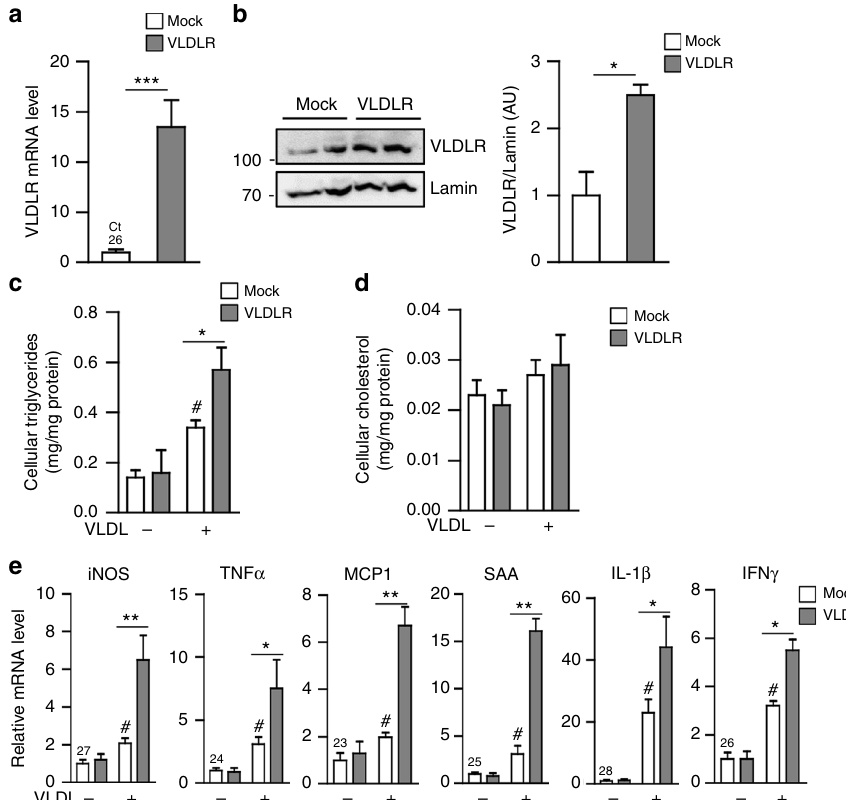
Fig. 2 Macrophages overexpressing VLDLR accumulate triglycerides and induce expression of pro-in fl ammatory genes in the presence of VLDL. Peritoneal macrophages were transfected with pcDNA3.1-mock (Mock) vector or pcDNA3.1-VLDLR (VLDLR) expression vector. Total RNA was isolated to analyze VLDLR mRNA expression ( a ) and whole cell lysates were extracted for western blot analysis ( b ). c – e Human VLDL (30 μ g/ml) was treated to cultures of peritoneal macrophages that had been transfected or not with VLDLR overexpression vector. Intracellular triglyceride ( c ) and cholesterol ( d ) levels in peritoneal macrophages. e mRNA levels of pro-in fl ammatory genes were analyzed with (+) or without ( − ) human VLDL challenges in peritoneal macrophages. Each mRNA level was normalized to cyclophilin mRNA. Data represent mean ± SD. # P < 0.05 vs. VLDL; * P < 0.05, ** P < 0.01, *** P < 0.001, Student ’ s t